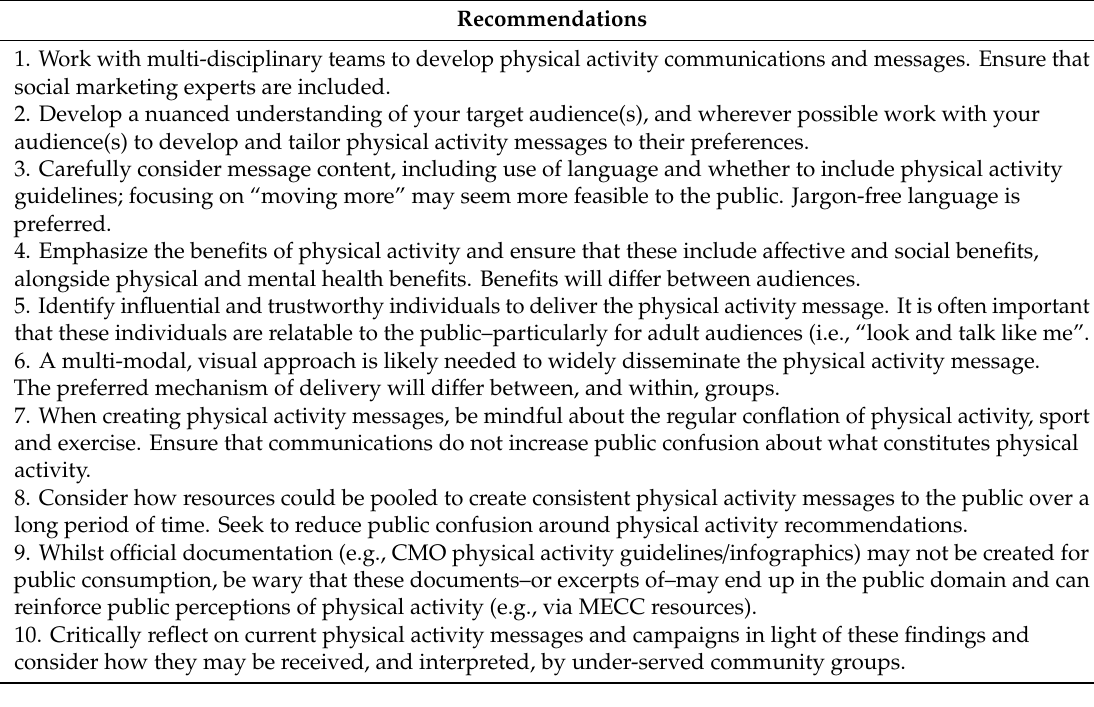
Table 4. The Bristol Recommendations for Improving Physical Activity